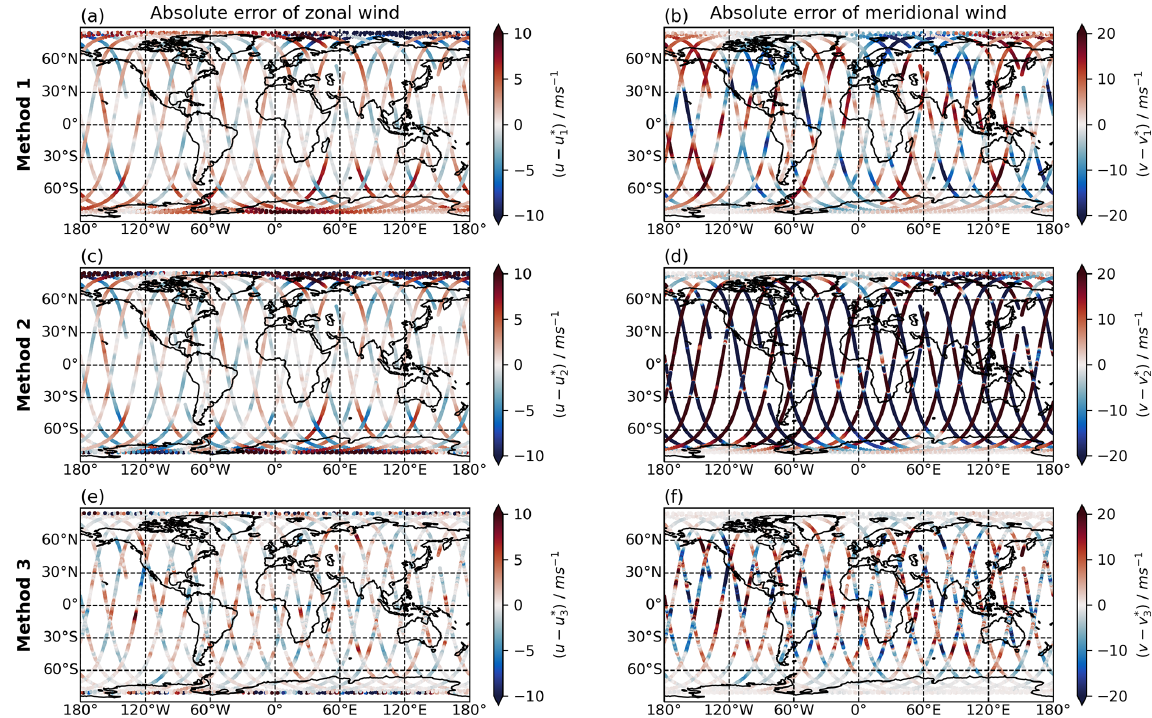
Figure 6. Maps of absolute errors of the different methods for zonal (a, c, e) and meridional (b, d, f) wind on 15 January 2021.